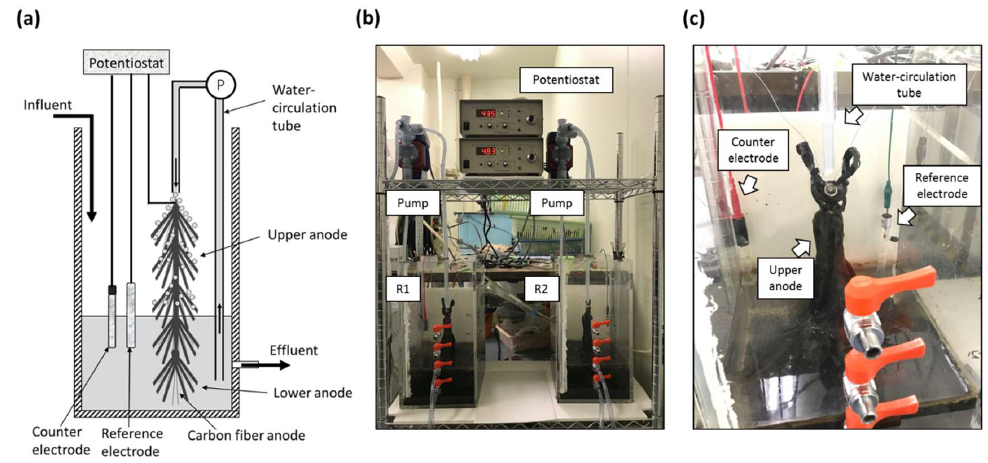
Figure 1. Diagrammatic representation ( a ) and pictures ( b , c ) of the bioelectrochemical system-trickling filter (BES-TF) reactor designed and tested in this study.